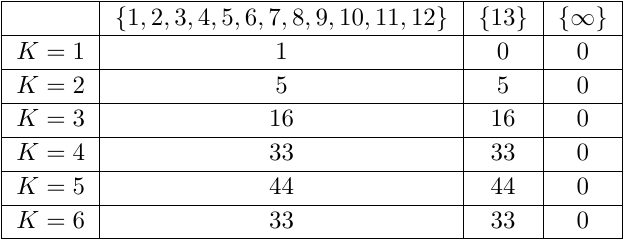
Table 10 . Number of Bethe roots for decomposed BAE with M = 13.